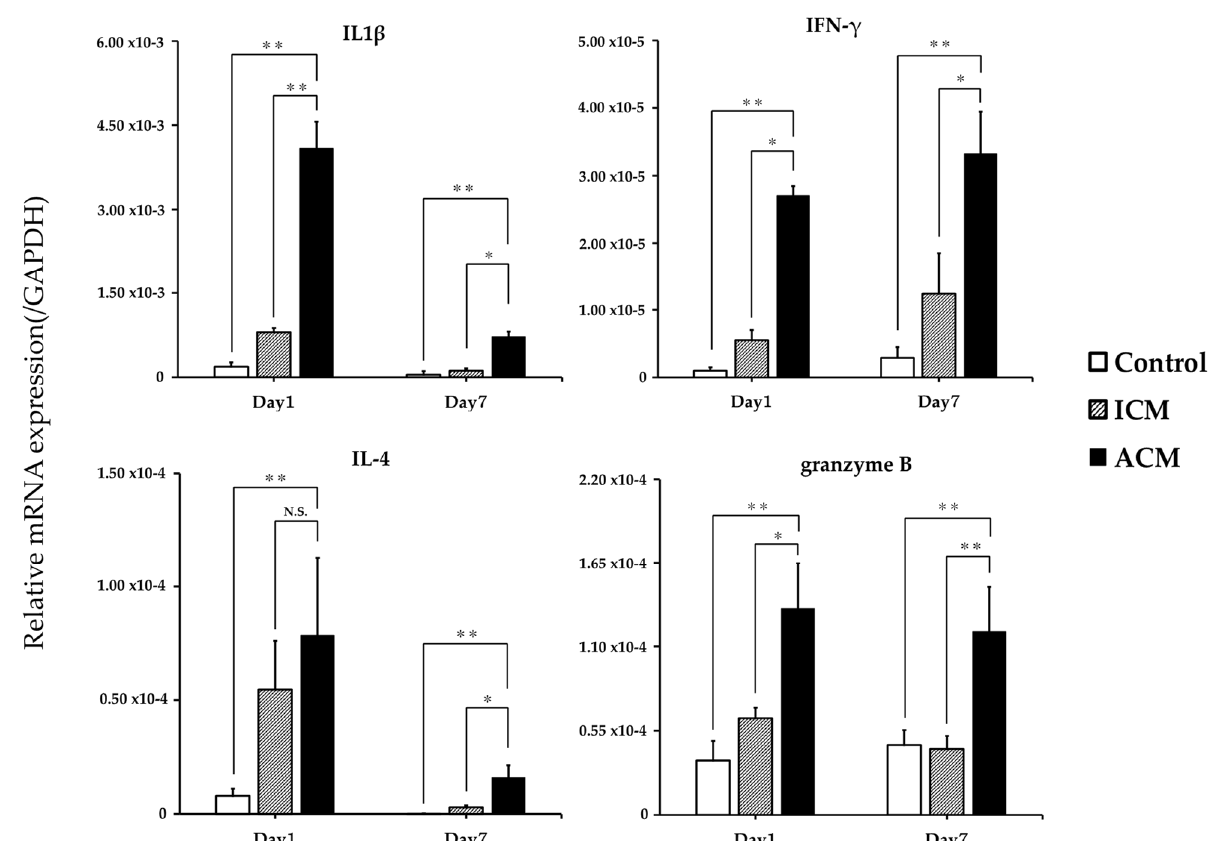
Figure 4. mRNA expression of T ‐ cell ‐ related cytokines in control, ICM, and ACM mice. At Days 1 and 7 post ‐ challenge, the mRNA expression levels of IL ‐ 1 β , IFN ‐γ , IL ‐ 4, and granzyme B in the oral mucosa (n = 8) were evaluated. The expression of the GAPDH gene served as an internal control. The mean and standard deviation are represented by bars and error bars, respectively. Kruskal– Wallis and Dunn’s multiple comparison tests were used to determine the statistical significance of differences (* p < 0.05, ** p < 0.01, N.S. = not significant).